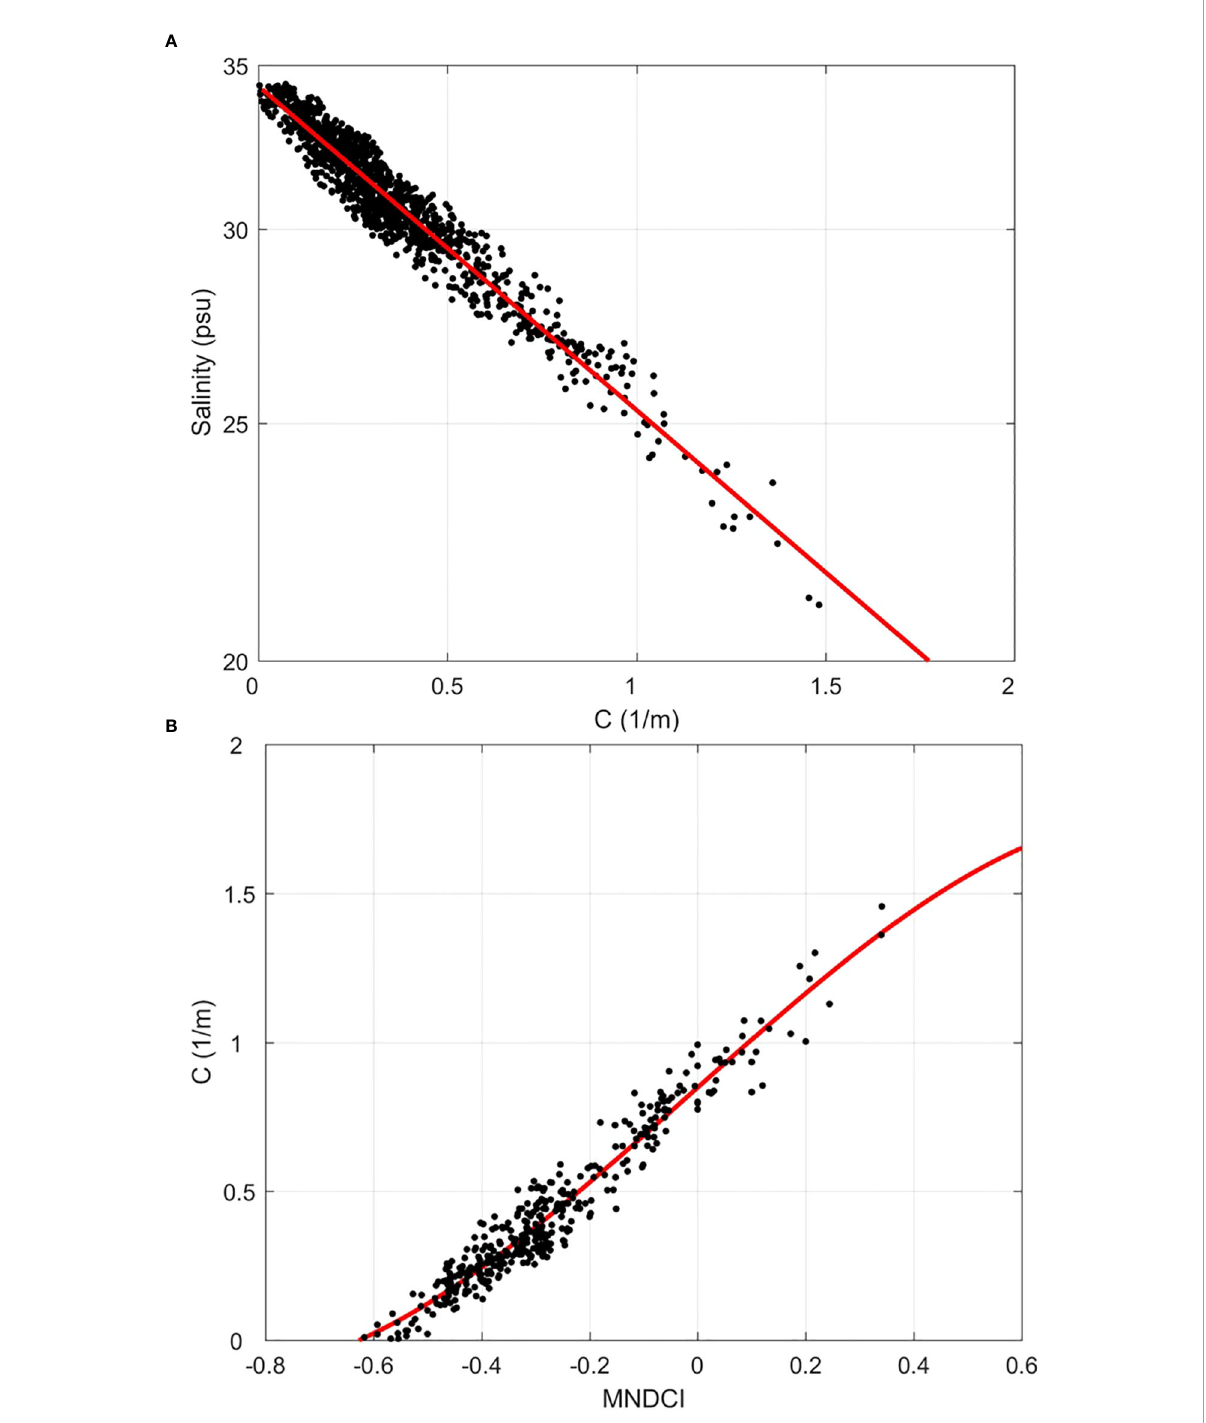
FIGURE 4 (A) Surface salinity as a linear function of beam attenuation, obtained by analyzing data from 1,345 sampling points during KIOST summer cruises. (B) Least-squares regression between beam attenuation coef fi cient and the maximum normalized difference carbon index (MNDCI). The MNDCI was calculated from the GOCI Rrs( l ) band ratio within the matched dataset in situ beam attenuation and synchronously obtained GOCI satellite